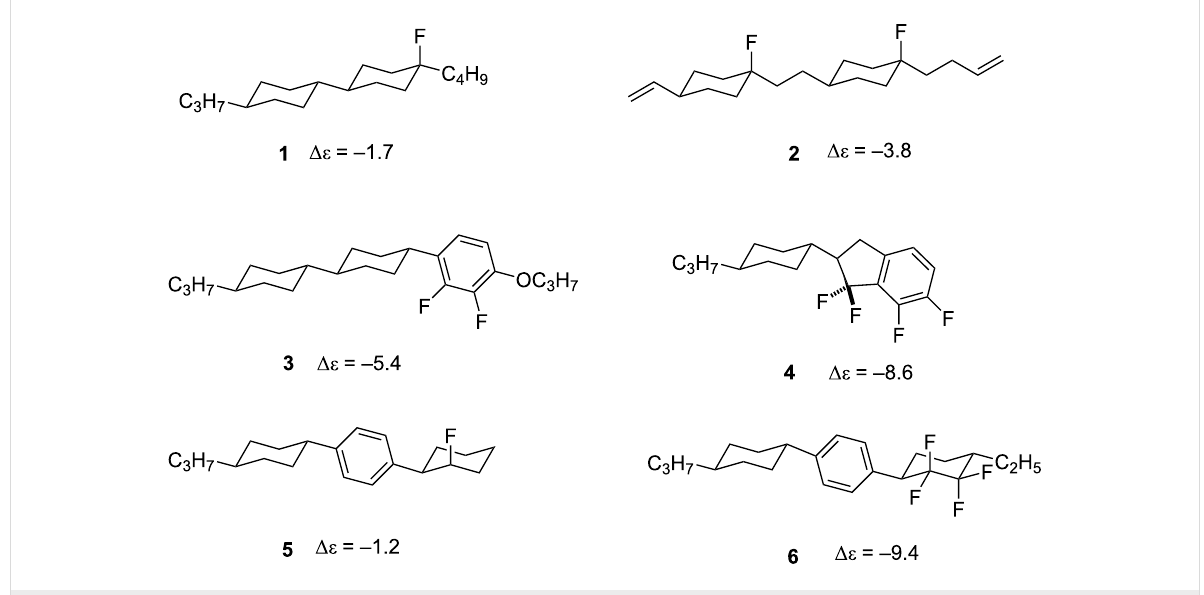
Figure 1: Examples of liquid crystal candidates with negative values for dielectric anisotropy ( Δε )